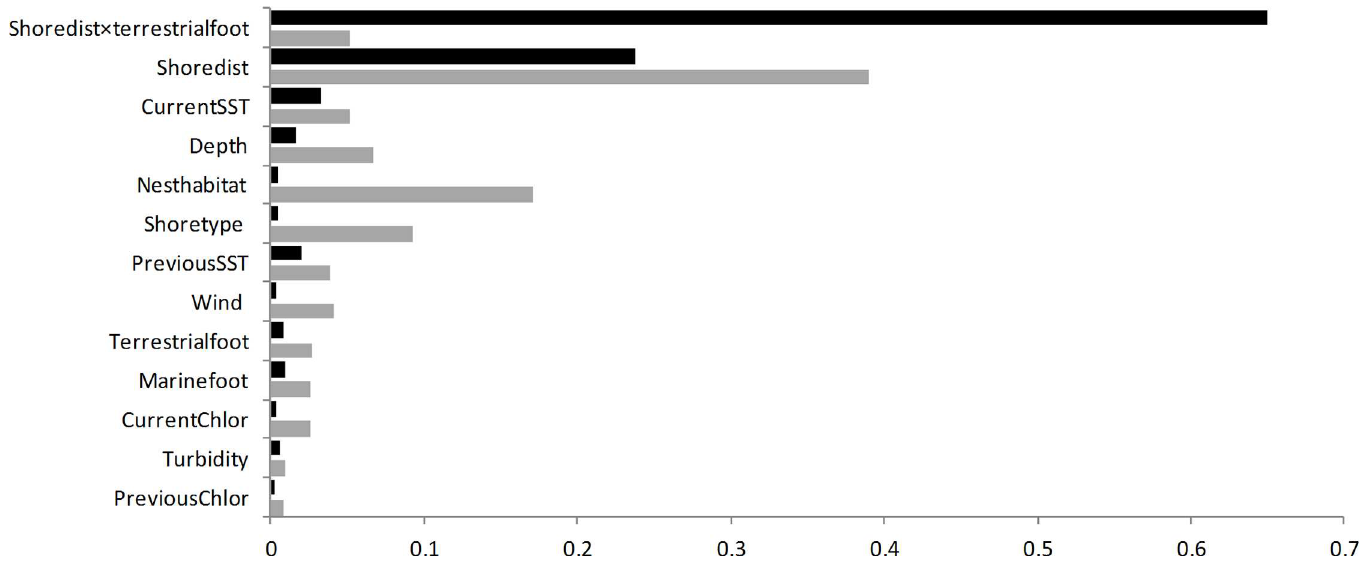
Fig 4. Relative influenceof variables explaining marineresource selectionmarbledmurreletsin northwesternWashington,U.S.A., and southwesternBritishColumbia, Canada,2004–2008. Black bars indicate relative influence based on effect of each variable on the numericalchange in the responsevariable (holdingothervariables constant)whereasgray bars indicaterelative influence based on ranking of standardized regression